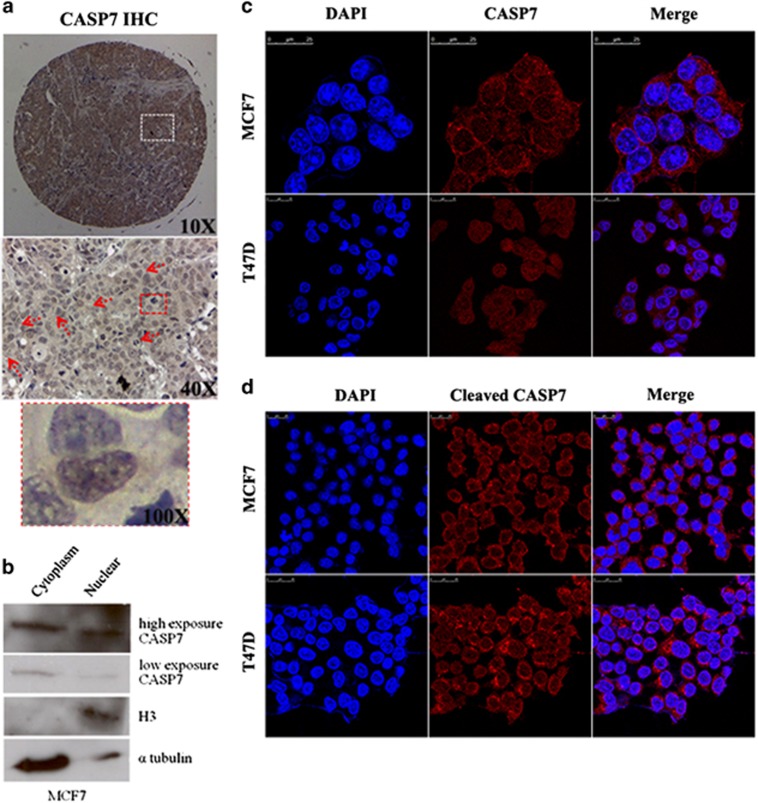
Localization of CASP7 and cleaved CASP7 in the nucleus. (a) TMA of breast carcinoma is stained with CASP7 antibody (ab32522). Arrow mark shows positive staining of CASP7 in the nucleus. (b) Western blot showing localization of CASP7 in the nucleus performed after cell fractionation of MCF7 cells. H3 and α tubulin are used to confirm the fractionation. (c, d) Localization of CASP7 and cleaved CASP7 was determined by indirect immunofluorescence using primary antibodies against CASP7 and cleaved CASP7 and alexa flour-conjugated antigoat and antirabbit secondary antibodies in MCF7 and T47D cell lines. DNA was stained with DAPI.